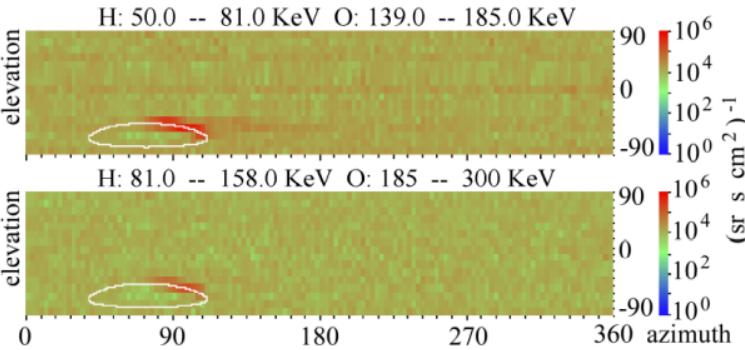
Figure 5. Examples of ENA images (2004 − 11 − 07 23:36:16 UT)